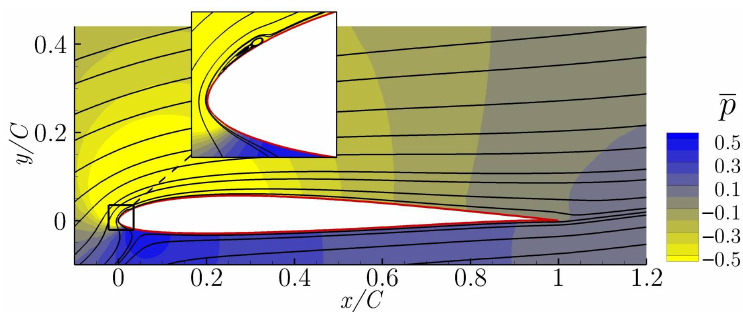
Figure 8. Averaged streamlines and pressure field of case 4 ( C l = 1.52).